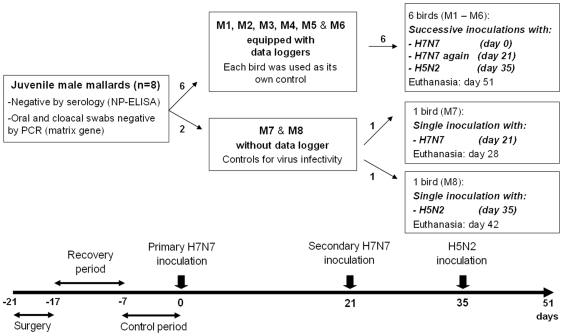
Experimental design.